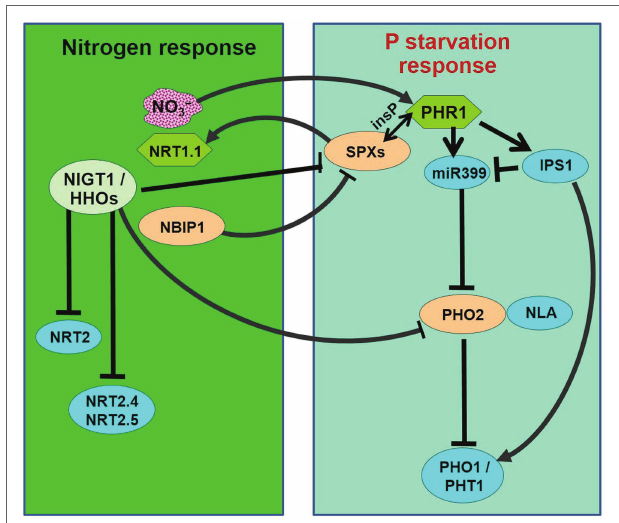
FIGURE 1 | Schematic representation of nitrogen-starvation response and phosphate-starvation responses explaining N/P interactions. PHR1 acts as a major transcriptional regulator of P-starvation response, which is accompanied by the activation of phosphate starvation-induced (PSI) genes followed by phosphate uptake and translocation by phosphate transporters (PHO1 and PHT1s). PHR1 is negatively regulated by SPXs through inositol polyphosphate (insP)-triggered Pathway. During P-starvation, PHR1 up- regulates the IPS1 and miR399 expression. miR399 represses PHO2, which acts in association with NLA (an E3 ligase) to repress/degrade PHO1 and PHT1. OsSPX4 is degraded through 26S proteasome pathway in response to N supply (+N) via the action of OsNRT1.1B and an E3 ligase OsNBIP1 (NRT1 − NBIP). SPXs transcription is directly repressed in response to +N by NIGT1/HHOs. On the contrary, PHR is positively regulated by +N. PHO2 expression is down-regulated in response to +N by NIGT1/HHOs and CHL1/ NRT1.1. Thus, the phosphate-starvation response is attenuated by N-starvation because of the accumulation of negative regulators (SPXs and PHO2) and a decrease in the positive regulator